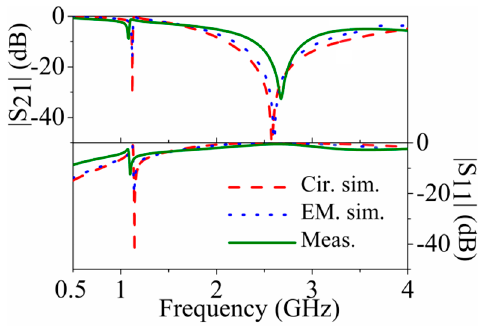
Figure 9. Electromagnetic simulation, circuit simulation and measurement response for the asymmetric structure of Figure 7b. Reprinted with permission from [11].